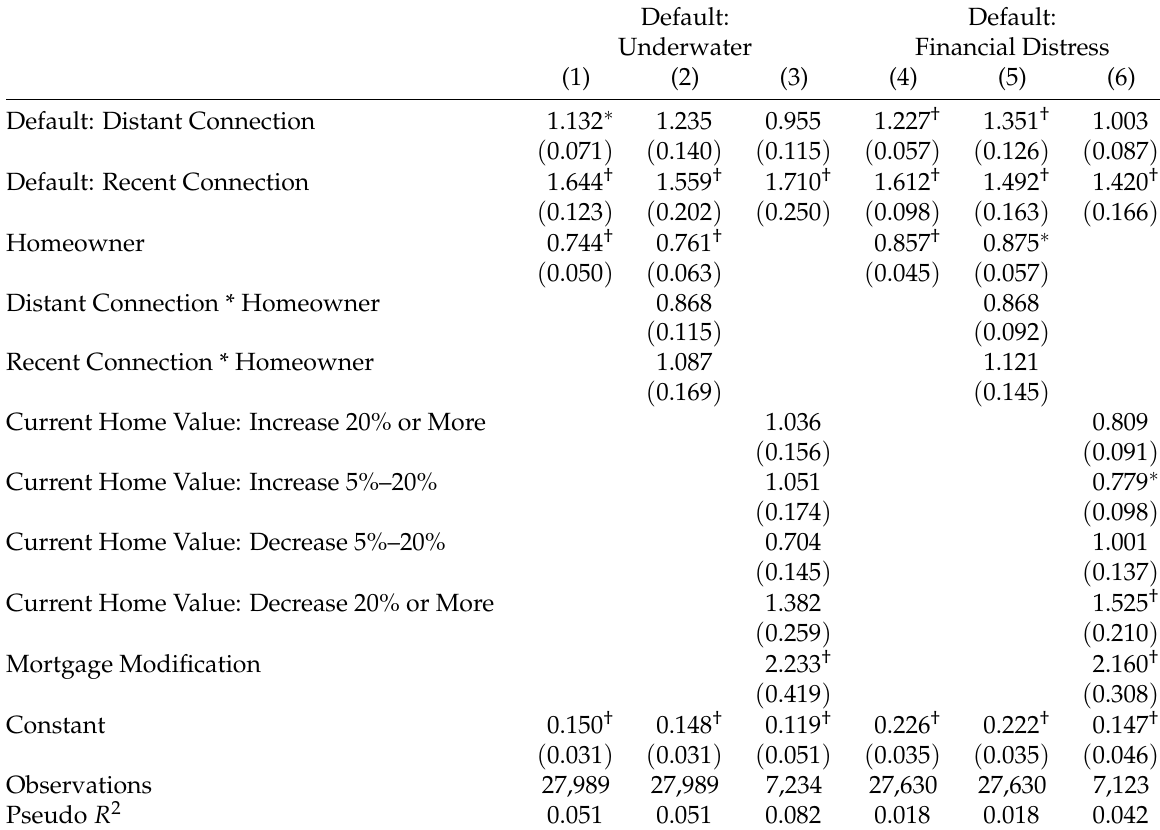
Table 3: Odds ratios from logistic regression of attitudes towards default.